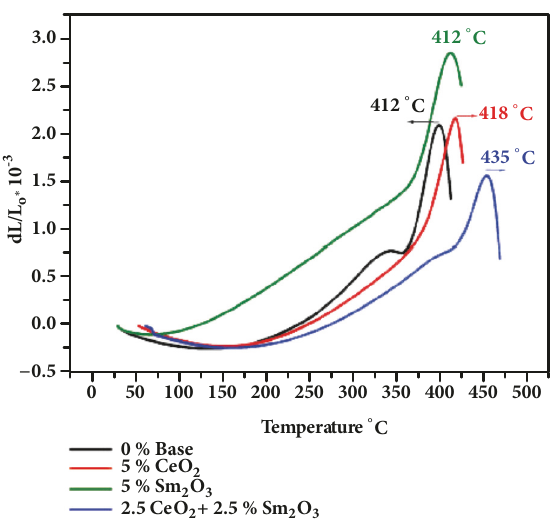
Figure 8: Dilatometric thermal expansion of some selected